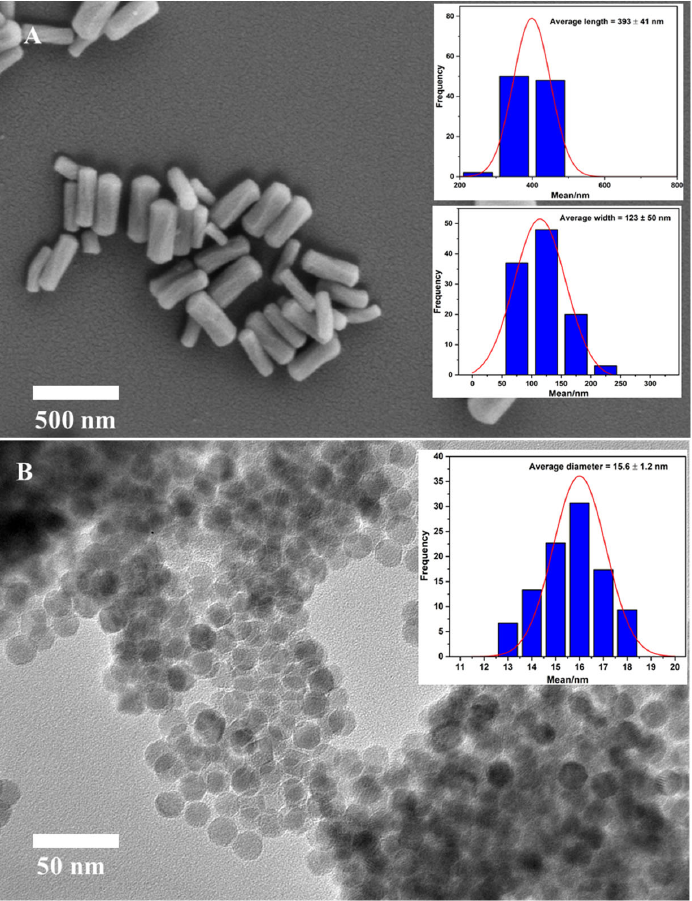
Figure 2. SEM image of synthesized MSR and its size distribution ( A ) and TEM image of monodis- perse Fe 3 O 4 NPs and its size distribution ( B ).